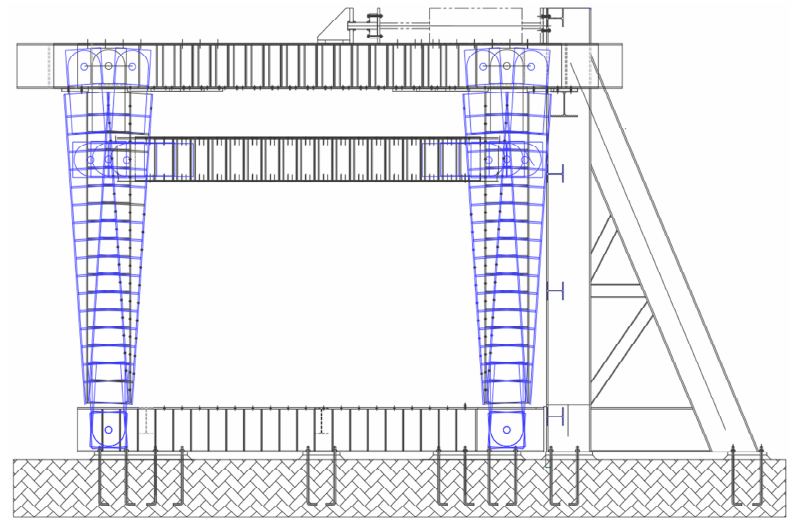
Figure 5. Frame movement.